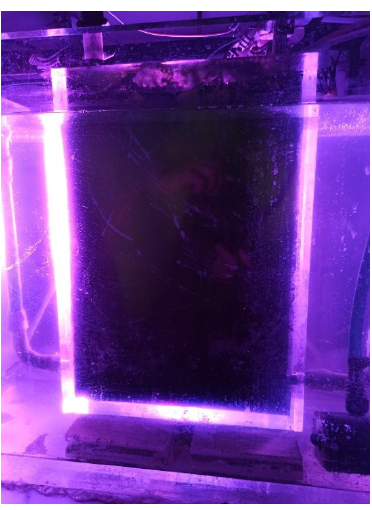
Figure 8. Lab-scale flat-panel